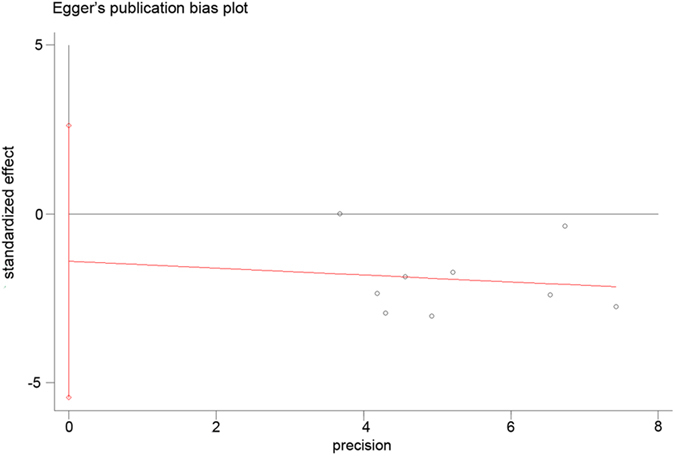
Egg’s test results of renal cell carcinoma patients’ 5-year OS rate.